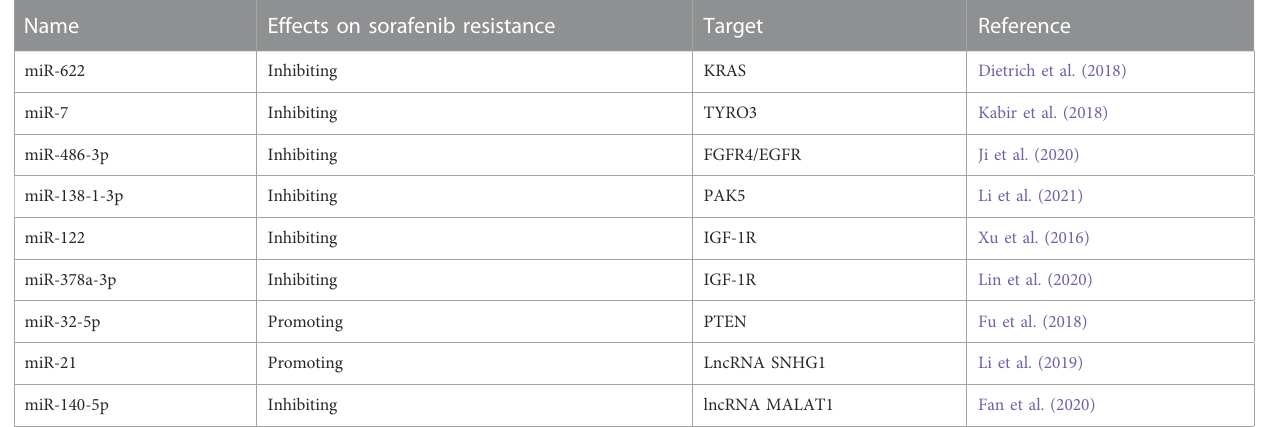
TABLE 2 Previous studies that show the involvement of miRNAs in sorafenib resistance in